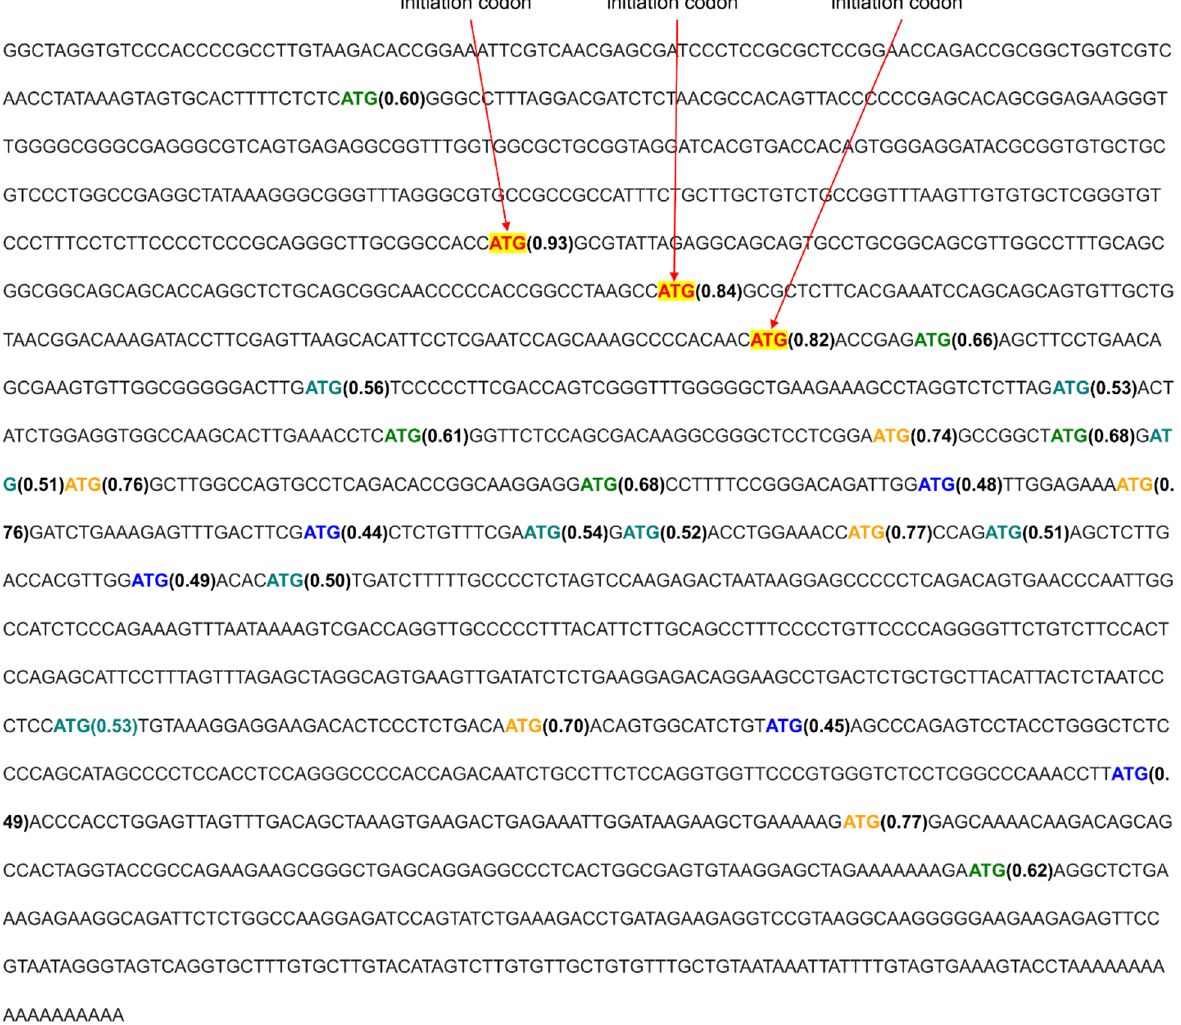
Figure 7. Mouse ATF4 transcript with ATG codons color-coded.